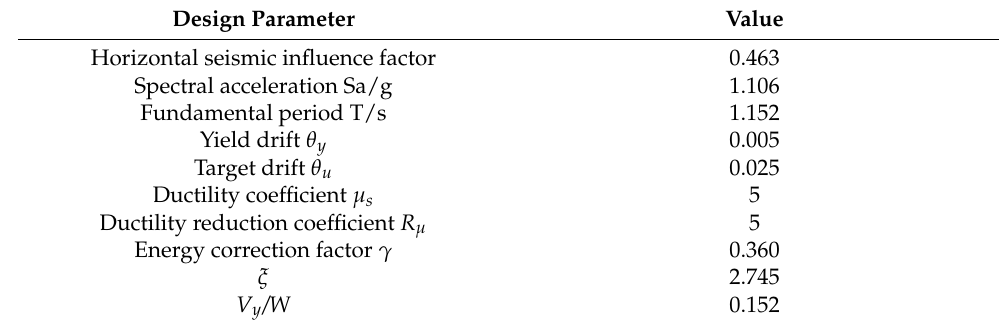
Table 10. Design Parameters for the structural model.